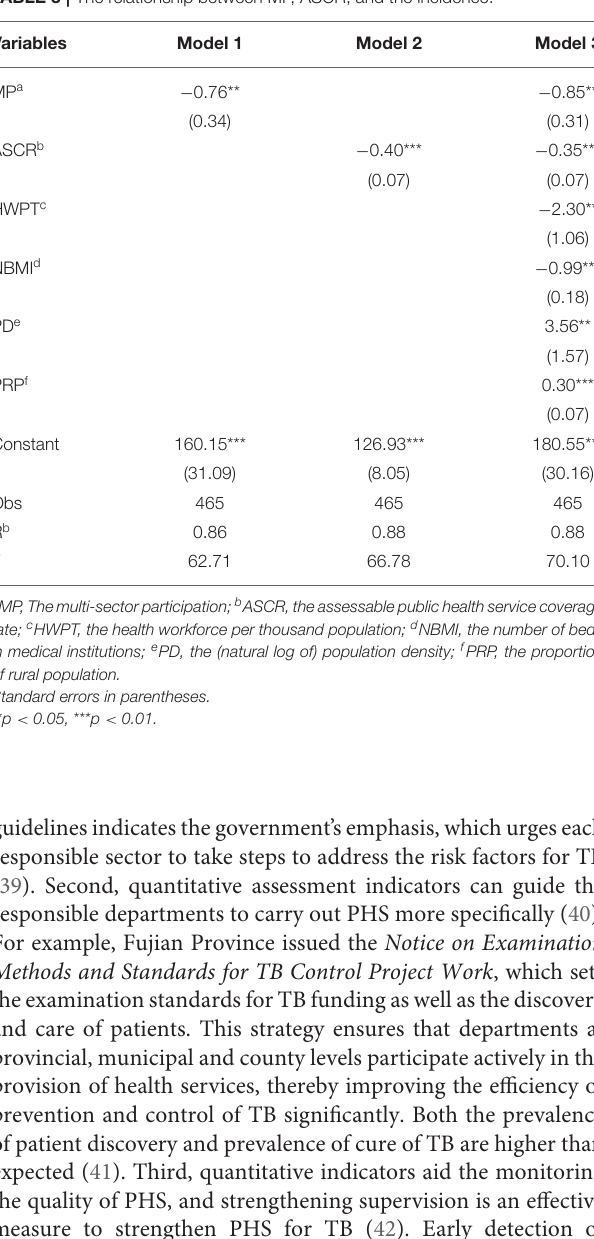
TABLE 3 | The relationship between MP, ASCR, and the